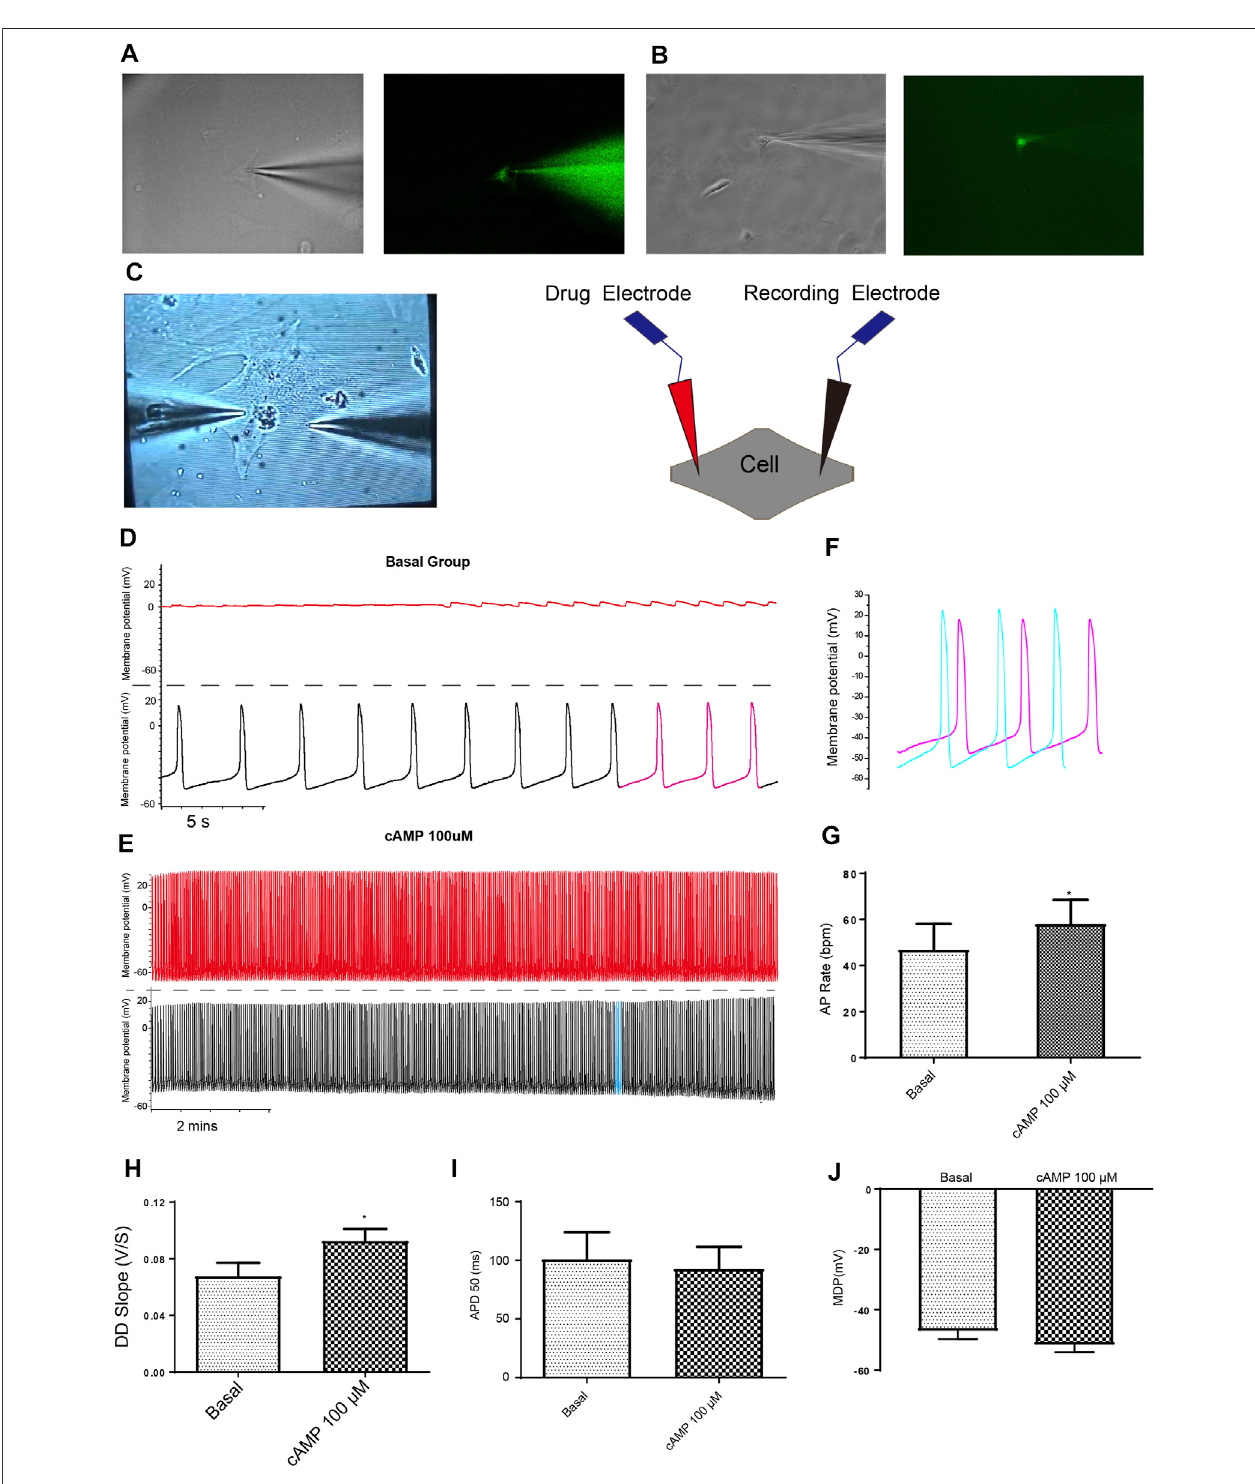
FIGURE 3 | Dual current patch clamp is an advantageous approach to investigate the effect of intracellular delivery of drugs on the APs of mESC-CMs reliably. (A) Ang II-FITC can be successfully delivered into mESC-CMs using the glass electrode as shown by the appearance of the green fl uorescence signal inside the cell. (B) CalciumindicatorFluo-4-IMcanbedeliveredintomESC-CMswithoutaleakfromtheglasselectrode. (C) BrightviewofadualcurrentpatchclampexperimentofmESC- CMs (left panel) . Aschematicdiagram on thedual patch clamp experimental con fi guration (right panel) . In dual patch clamp, APmeasurementwill fi rst bemade using the “ recording electrode ” [as shown by black tracesin (D) and (E) ; on the other hand, red tracesin (D) and (E) represent recording inthe “ drug electrode ” ].Before